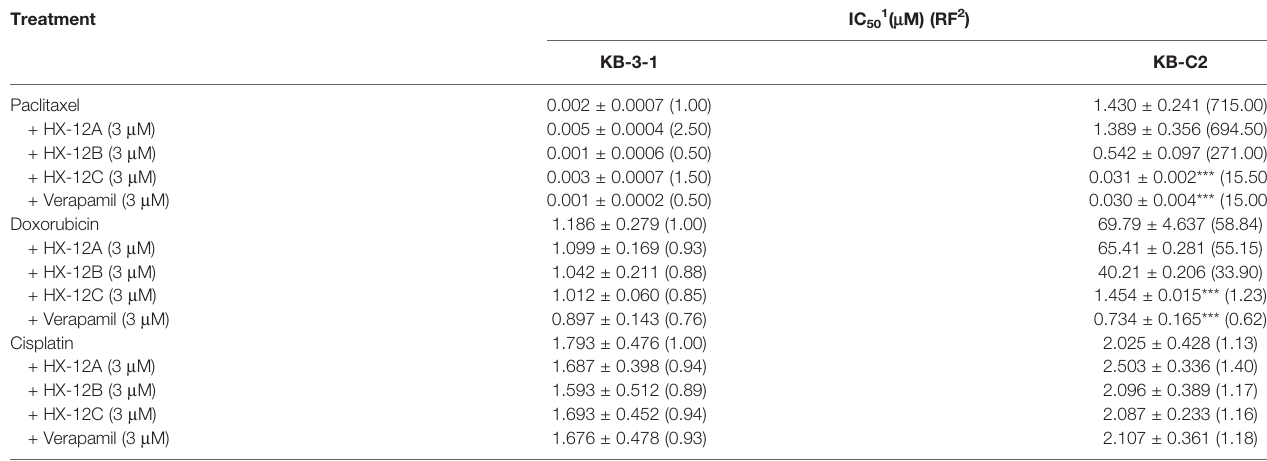
TABLE 1 | Reversal effect of three peptides on drug-selected ABCB1-overexpressing cells.